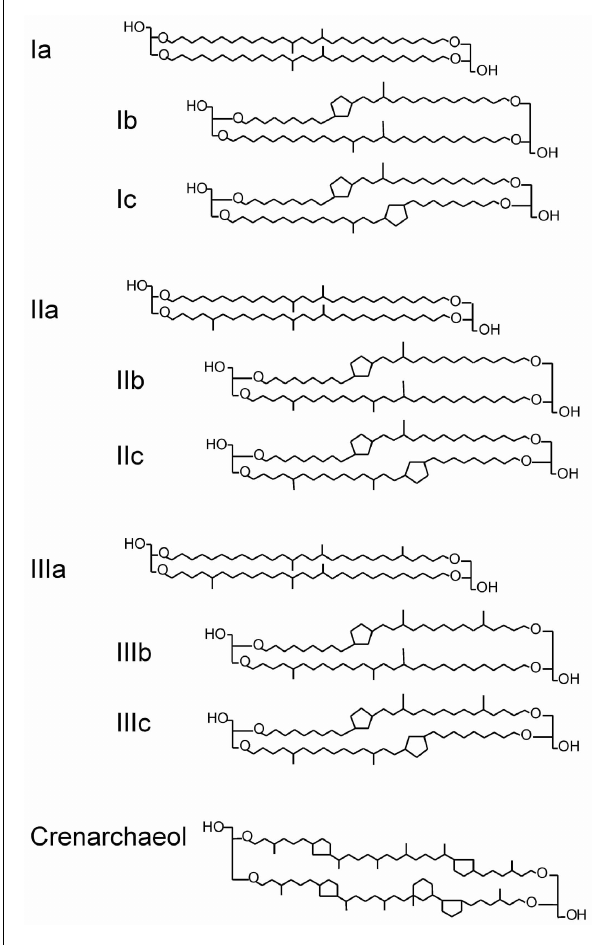
FIGURE 1 | Chemical structure of brGDGTs (Ia–IIIc) and crenarchaeol.